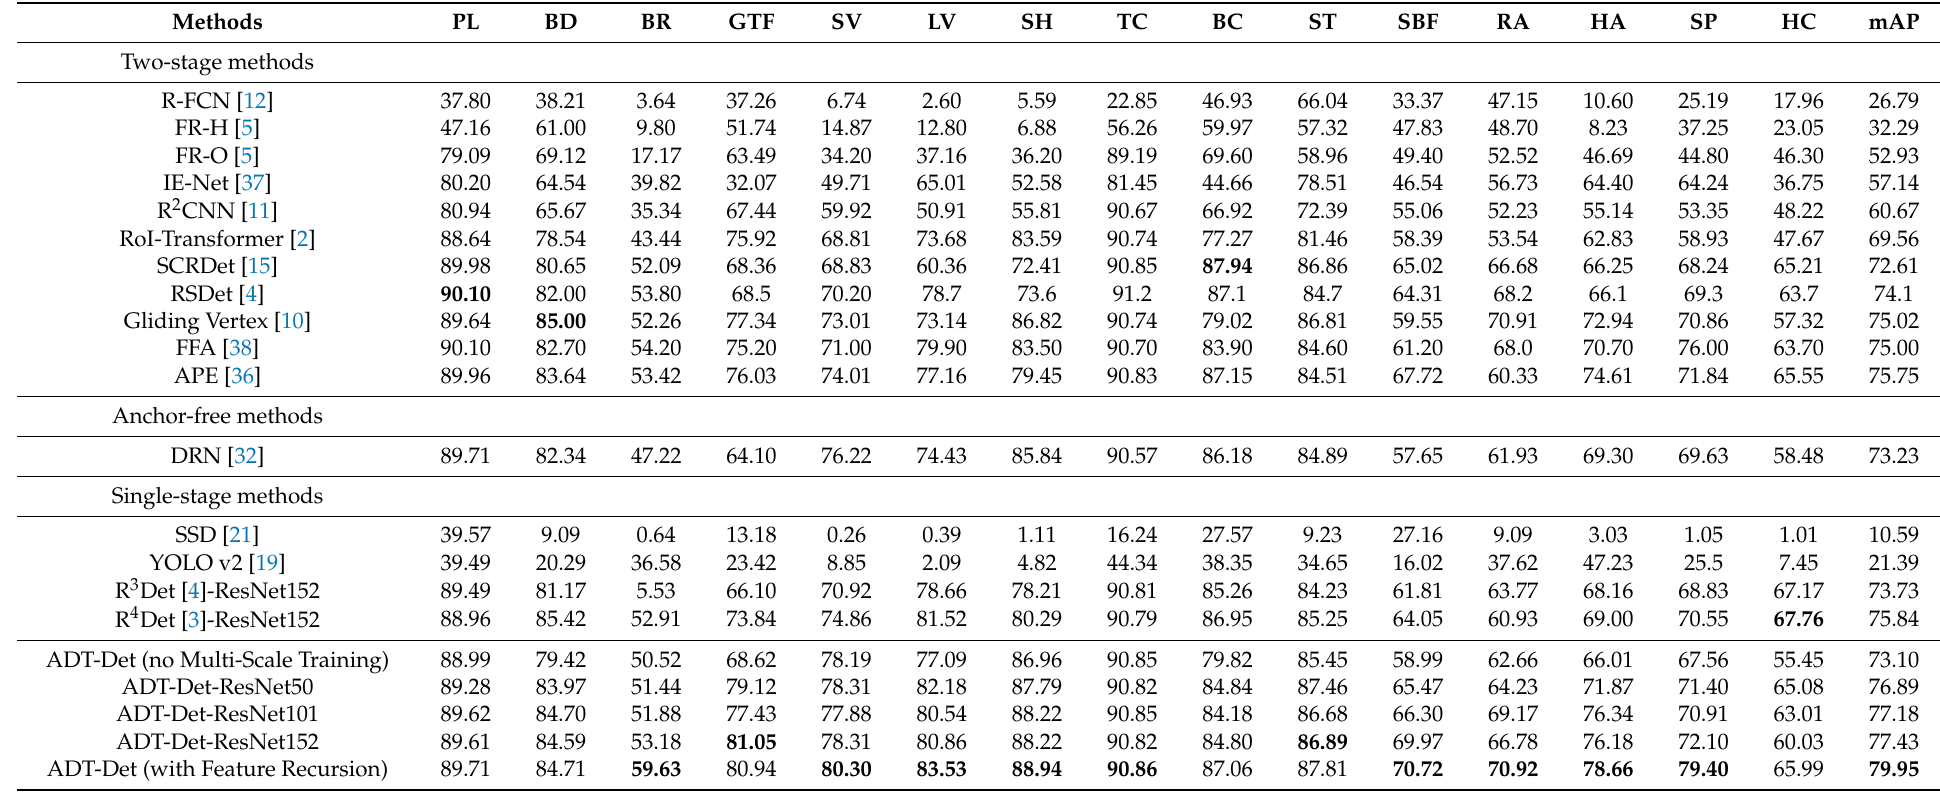
Table 3. Detection accuracy on different objects (AP) and overall performance (mAP) evaluation on